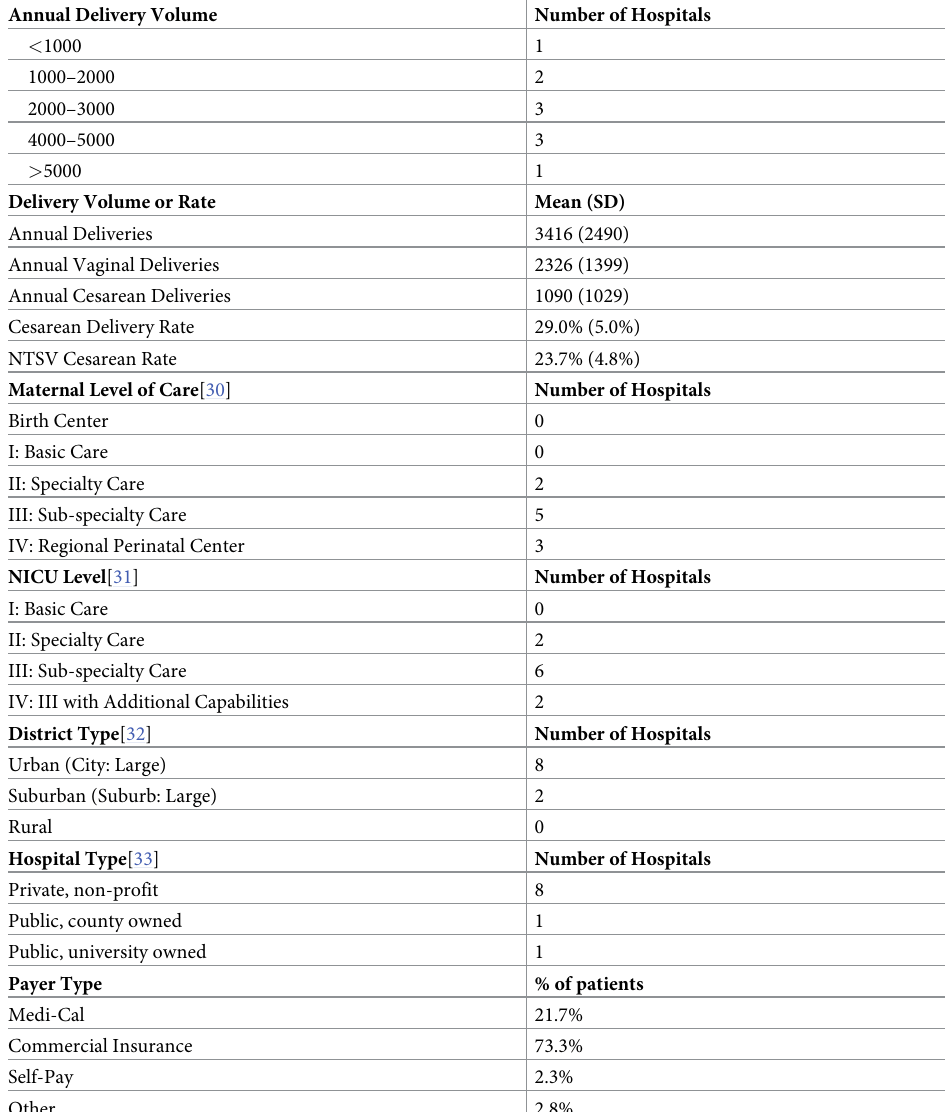
Table 1. Hospital